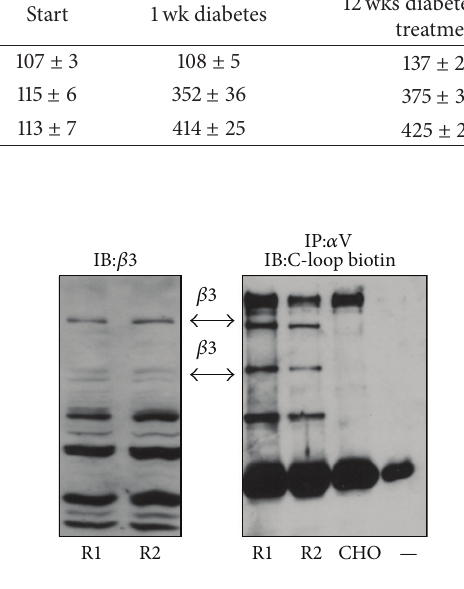
Figure 1: Biotin labeled C-loop antibody binding to 𝛽 3 in rat kidney lysates from two diabetic rats (R1 and R2) as well as lysate from CHO cells (that do not express 𝛽 3) was immunoprecipitated (IP) with an anti- 𝛼 V antibody and then immunoblotted (IB) with a biotin labeled C-loop antibody (C-loop biotin). RIPA buffer alone was used as an additional negative control ( − ). Binding of the C-loop antibody to 𝛽 3 in the kidney lysate but not to the CHO lysate was visualized with avidin HRP and enhanced chemiluminescence. To demonstrate that the specific band recognized by the C-loop biotin antibody corresponded to 𝛽 3, lysates were also immunoblotted with an anti- 𝛽 3